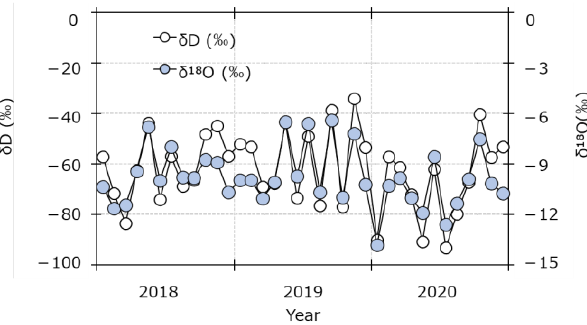
Figure 7. Trends of δ D and δ 18 O in the precipitation measured at Hirosaki City (2018 to 2020).